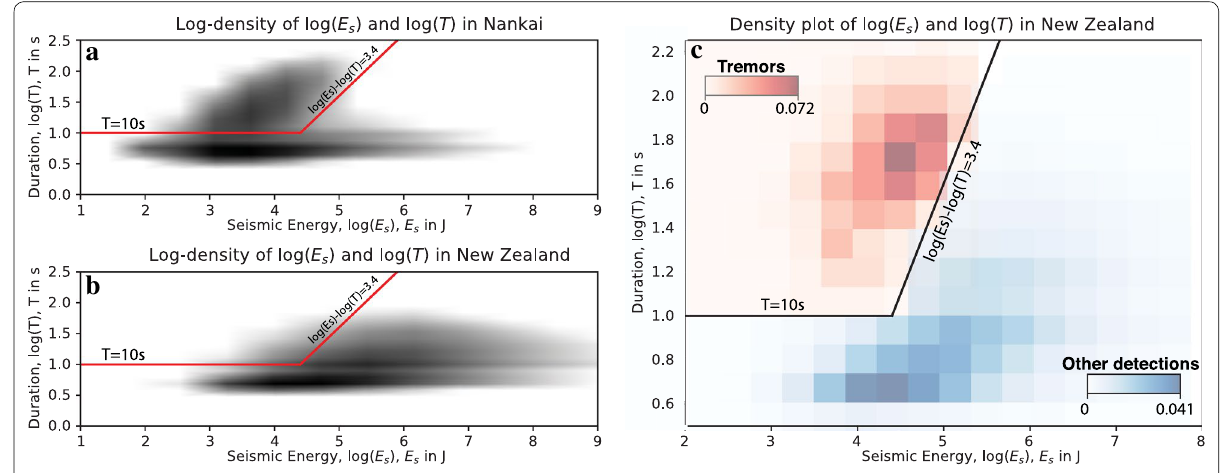
Fig. 2 a Log ( E s ) − log ( T ) density plot for all the detected events in the Nankai Subduction Zone (Idehara et al. 2014). b Log ( E s ) − log ( T ) density plot for all the detected events in New Zealand. c Log ( E s ) − log ( T ) density plot for the tremors and other detected events in New